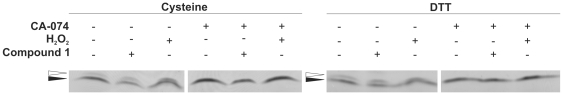
Compound 1 induces oxidative changes in the active site of cathepsin B.Cathepsin B (2 µg) was incubated with DMSO or CA-074 (50 µM) for 15 min at RT in activation buffer with respective reducing agent at 5 mM. Afterwards, the samples were incubated with DMSO, compound 1 (500 µM) or H2O2 (490 µM) for 5 h at RT. 4 µl of each sample was then loaded on precast isoelectric focusing gel (pI range 3.0–9.0), separated on the Phast System and stained with Coomassie blue. Black and white arrows are used to denote the active and the oxidized isoforms of cathepsin B, respectively.